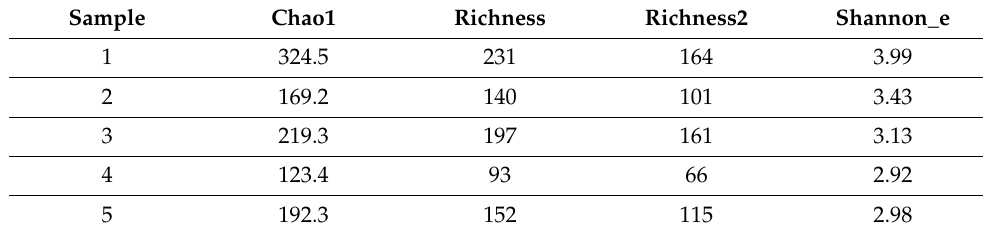
Table 2. Indices of species diversity for biofilms #1–#5 (correspond to biofilms described above).